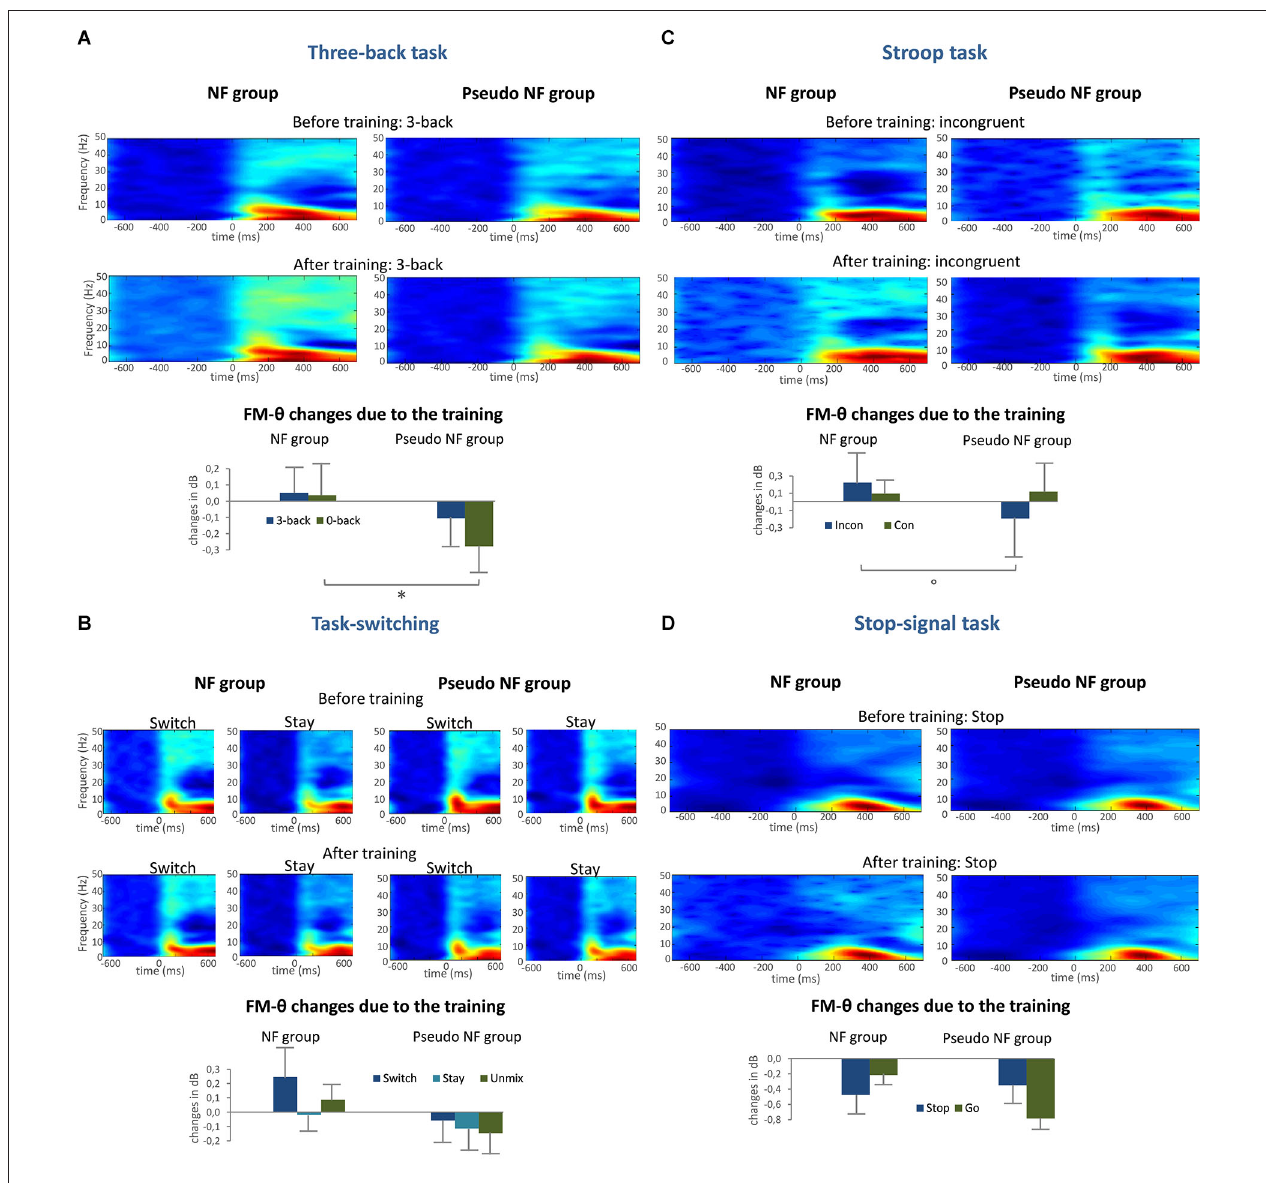
FIGURE 7 | Provides the mean ERSPs before and after training, as well as the extracted fm-theta changes (and standard error of mean) for all conditions as bar charts for the three-back condition in the three-back task (A), the switch and stay